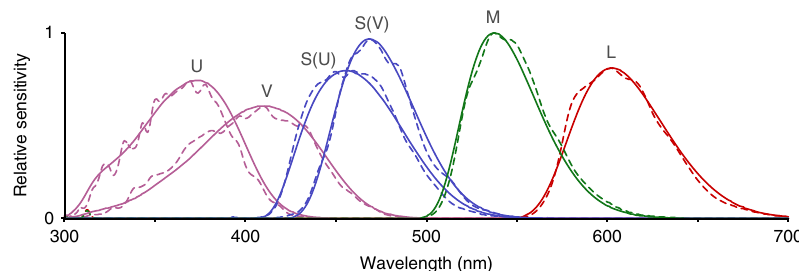
Fig. 1 Spectral sensitivities of avian cones and multispectral camera channels. Solid lines show spectral sensitivities of avian cones and dashed lines show multispectral camera channels. Most terrestrially foraging birds are tetrachromats, having L, M, and either S(U) and U or S(V) and V cones 6 . L, M, S, V, and U stand for Long, Medium, Short, Violet, and Ultraviolet wavelengths,